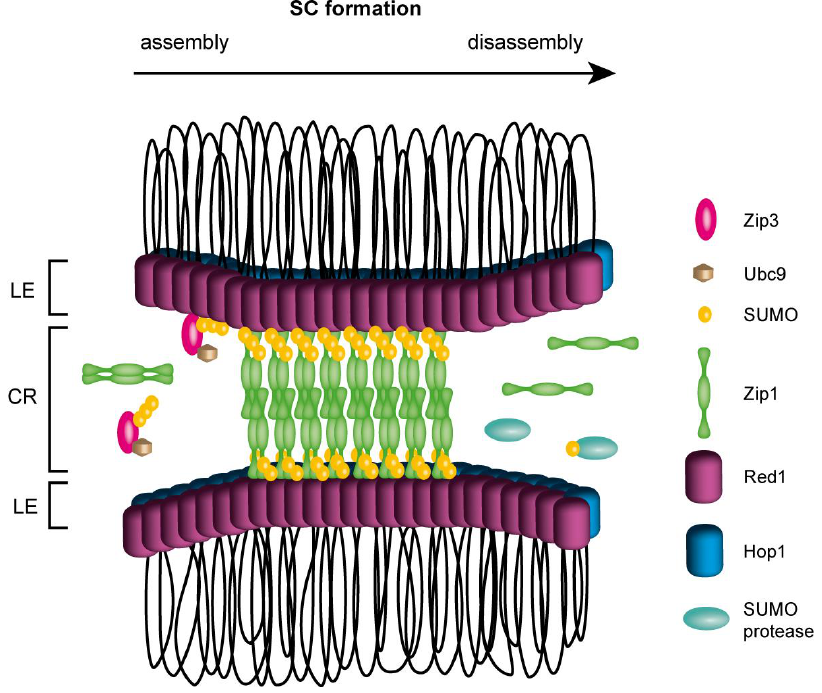
Figure 2. The formation of synaptonemal complex (SC). During SC assembly Zip3 recruits Ubc9 and SUMO to the synapsis sites thus facilitating formation of SUMO chains and conjugation of SUMO to other proteins (such as Red1). Zip1 dimers polymerize along the lateral elements (LE) where they can bind to Red1 and SUMO chains leading to generation of central region (CR). SC disassembly could proceed by dissociation of SUMO conjugates by the action of SUMO proteases or other counteracting mechanism. For clarity, Red1 and Hop1 along LEs are illustrated, even though the exact distribution of Hop1, Red1 and sumoylated Red1 is